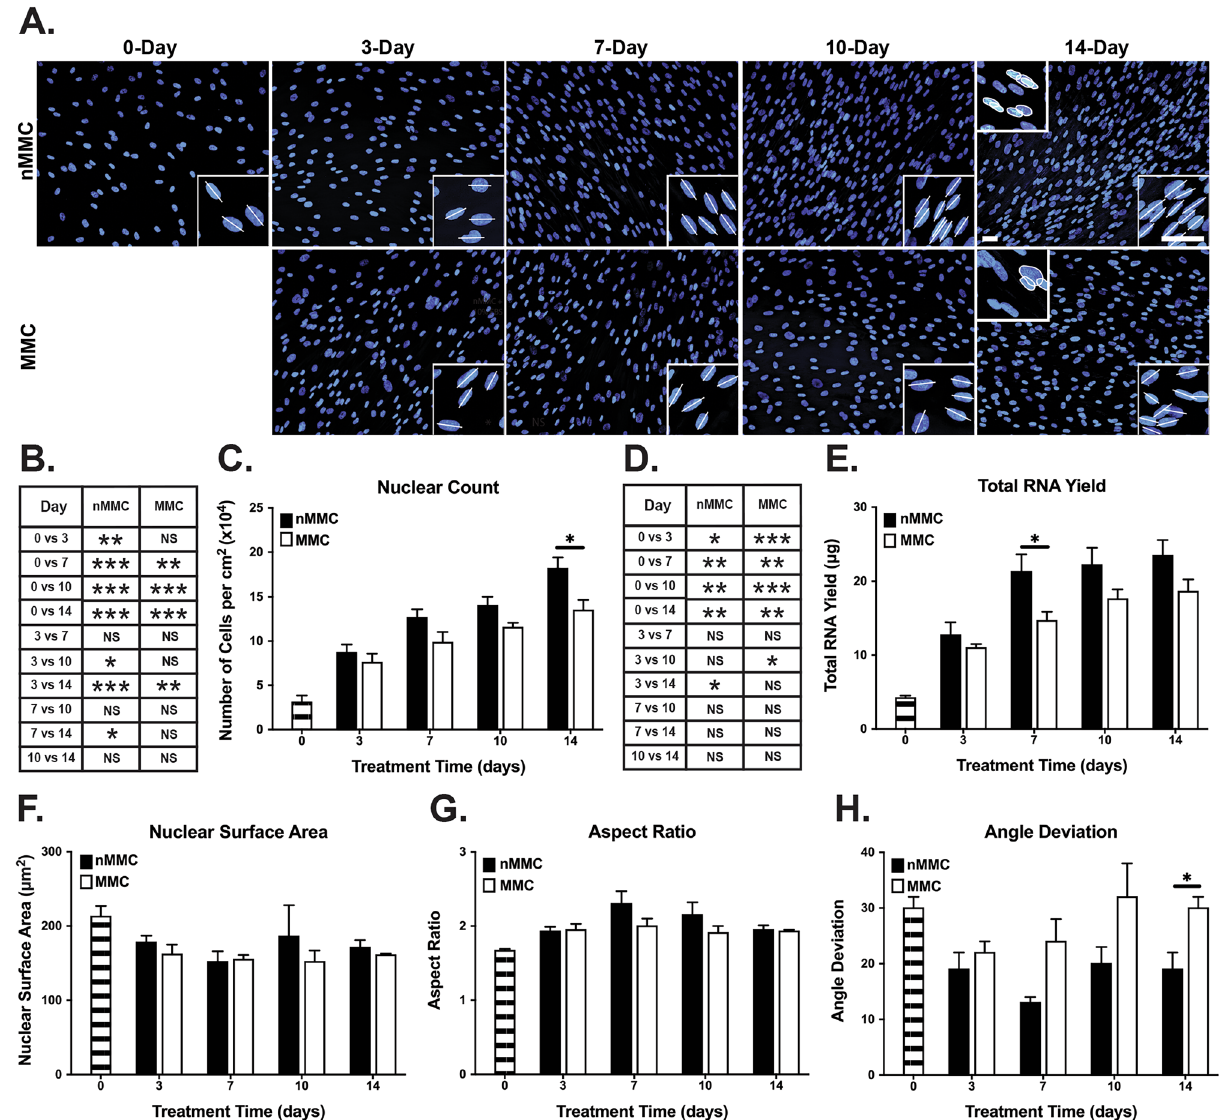
Figure 2. Characterization of cell numbers, morphology, and orientation in MMC and nMMC cultures over time. ( A ) Representative standardized images of the cultures with nuclear DAPI stain over time. Lower inserts show higher magnification images of select areas with long axis of the nuclei indicated by a line. Upper inserts in 14-day images show nuclear overlap as indicated by white tracing of the outlines of nuclei. Magnification bars = 40 μm. ( B ) Statistical comparison of change in cell numbers based on calculation of DAPI stained nuclei over time (n = 4 repeated experiments). ( C ) Pairwise comparison of cell numbers based on calculation of DAPI stained nuclei at each time point (n = 4 repeated experiments). ( D ) Statistical comparison of change in total RNA yield over time (n = 6–7 repeated experiments). ( E ) Pairwise comparison of total RNA yield at each time point (n = 6–7 repeated experiments). Comparison of nuclear surface area ( F ), aspect ratio ( G ), and angle deviation ( H ) in DAPI stained images over time (n = 3 repeated experiments). Results show mean + /− SEM from repeated experiments ( C,E–H ). Statistical testing was performed by one-way ANOVA ( B , D ) and independent samples t-test ( C , E–H ), *p < 0.05; **p < 0.01; ***p <